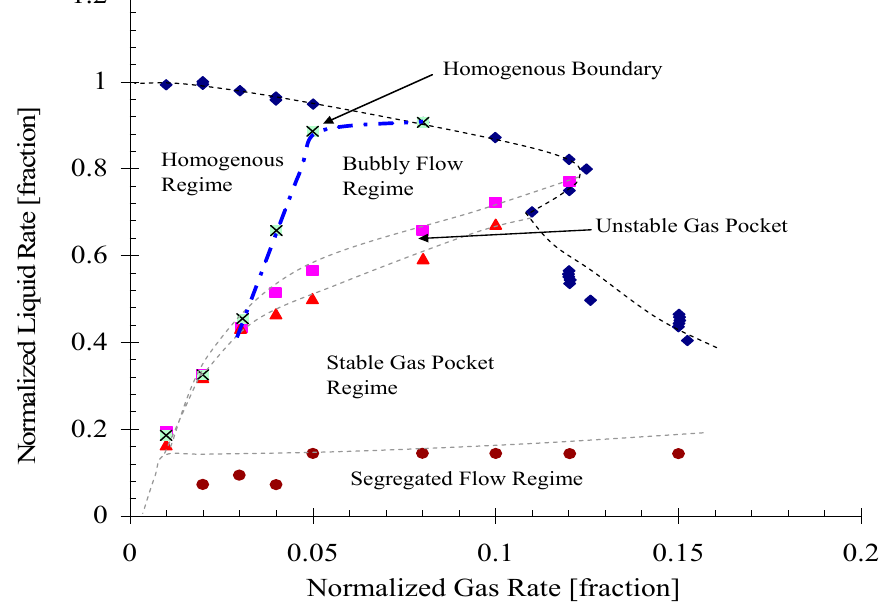
Figure 9. Flow pattern map for GC-6100 ESP at 2400 rpm and 150 psig [39].